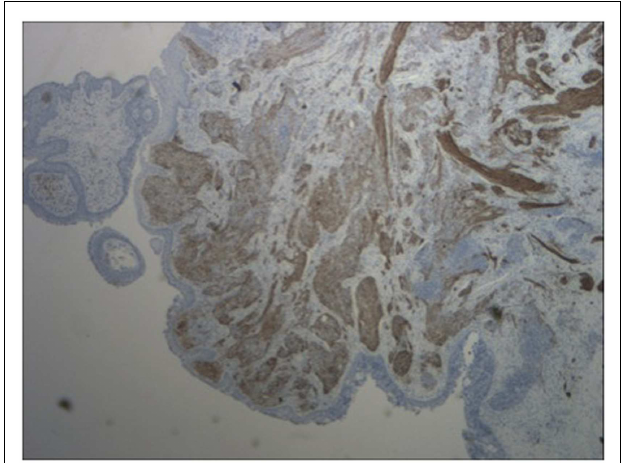
FIGURE 5 | Immunohistochemistry of lesion for neurofilament stain (characteristically stains positive in esthesioneuroblastoma).